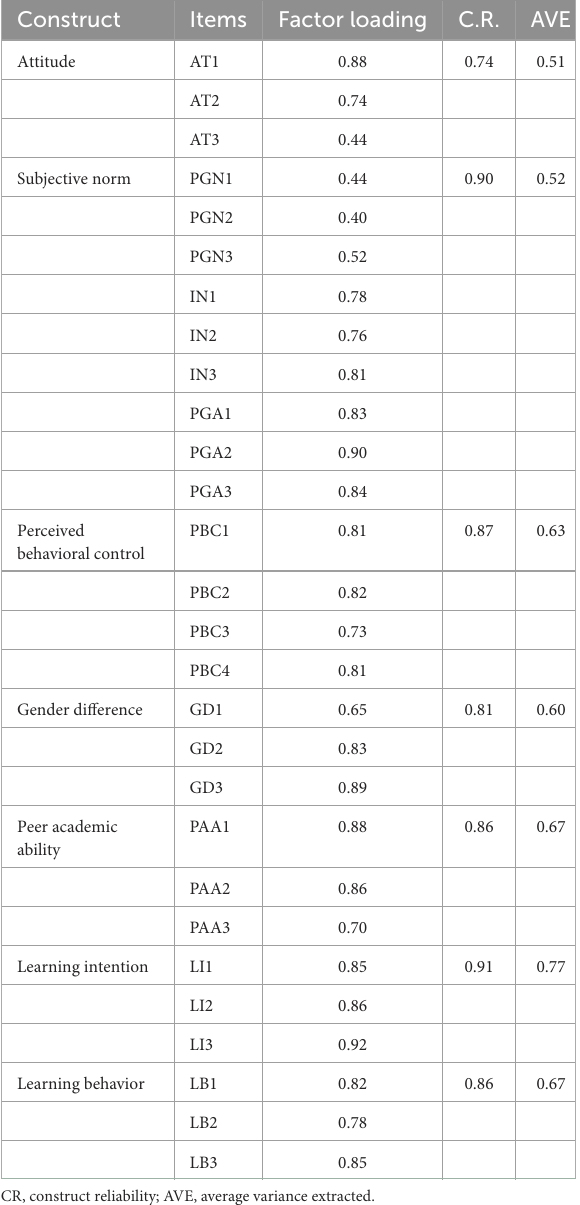
TABLE 2 The results of factor analysis.